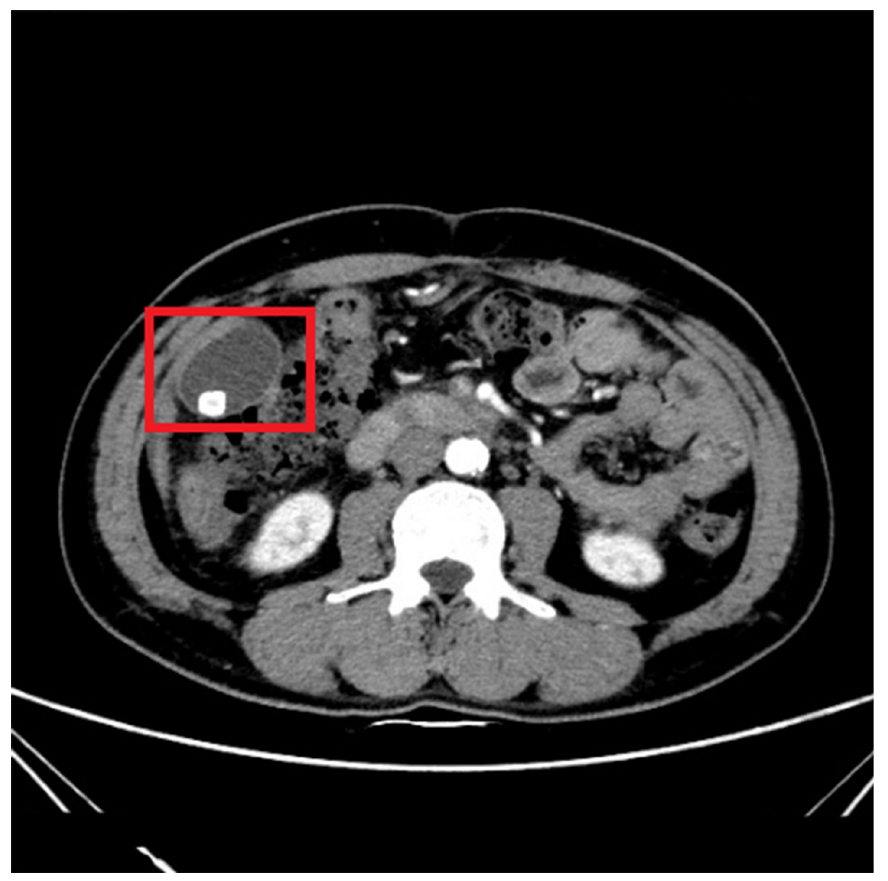
Fig 3. The original CT images of a person with the